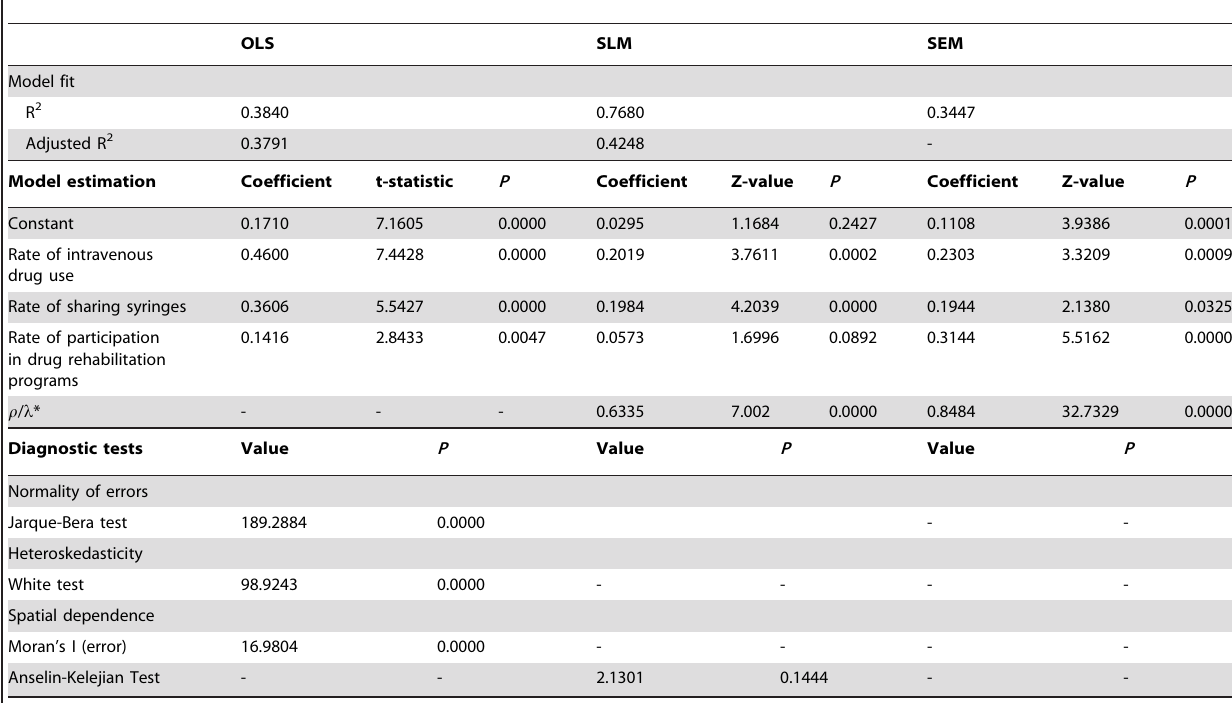
Table 2. Association of the prevalence of HCV and risk factors.